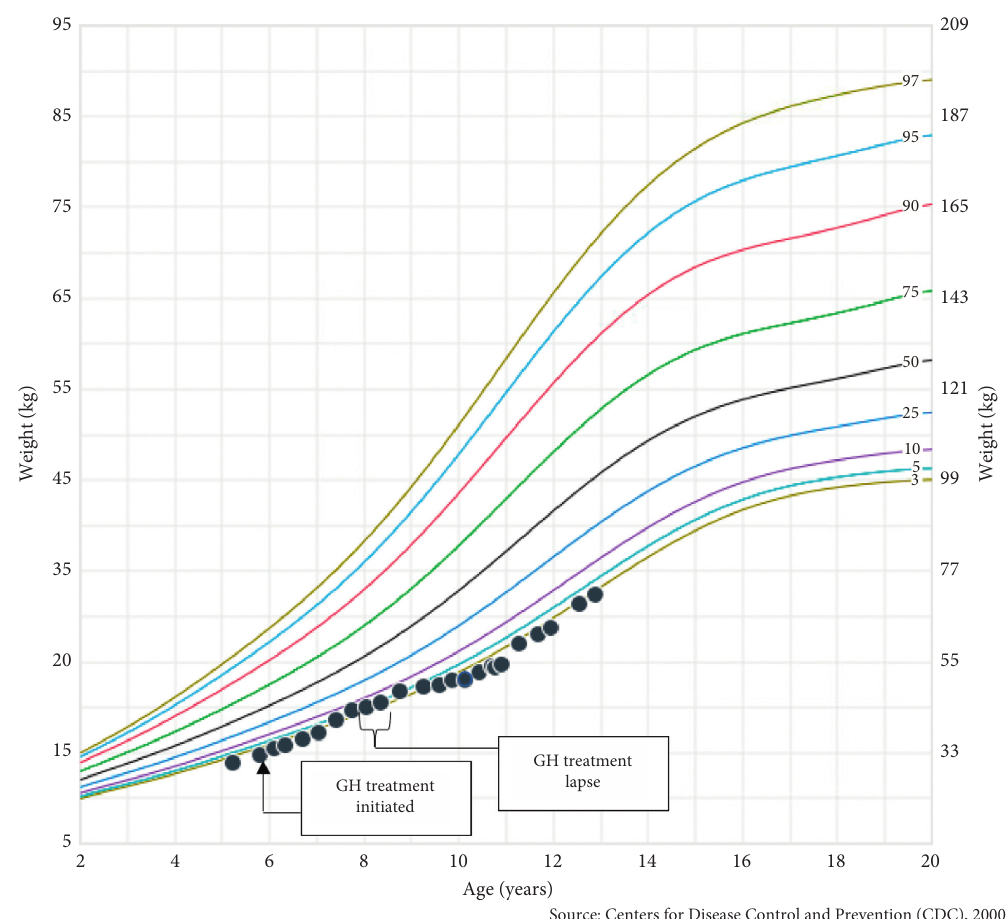
Figure 1: Plotted weight-for-age percentiles for Jane Doe. Centers for Disease Control and Prevention (CDC) weight-for-age percentiles, girls 2 to 20 years